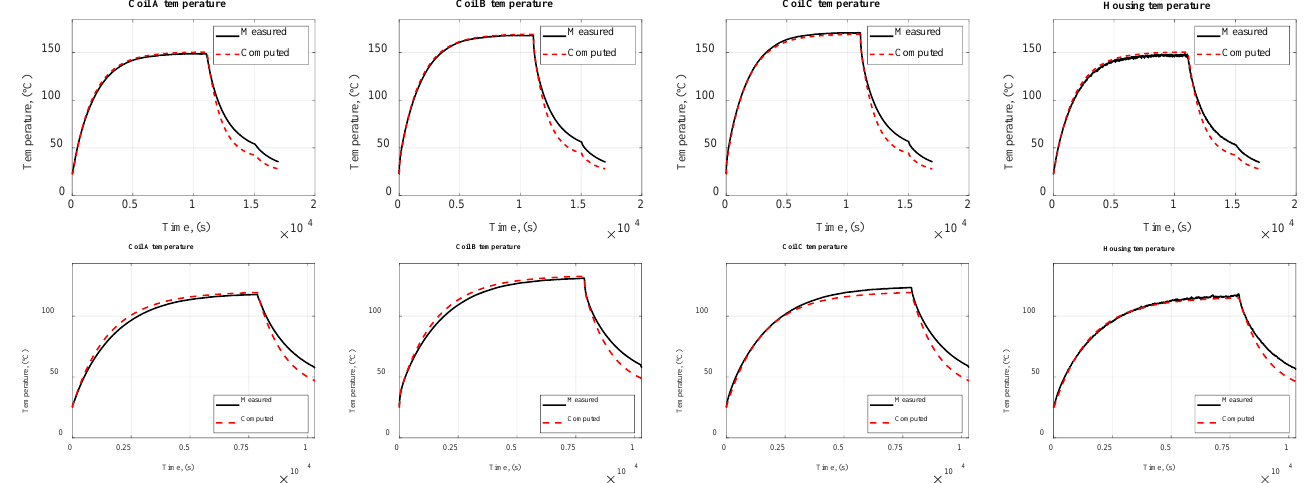
Figure 18. Measured and computed temperatures for the long-time pulse tests: in configuration A (top); in configuration B (bottom).